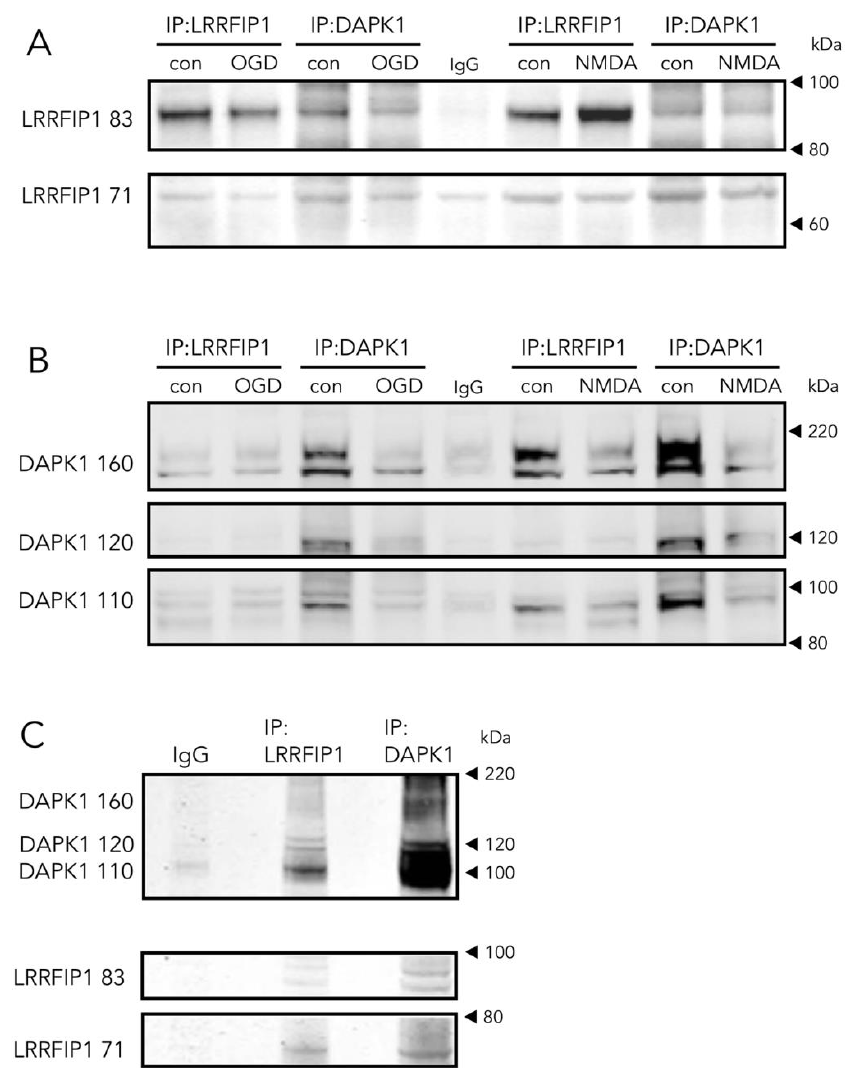
Figure 6. Direct and reverse co-immunoprecipitation of LRRFIP1 during ischemia in vivo and excitotoxicity in vitro . ( A , B ) WB showing the effect of OGD or NMDA on direct and reverse co-immunoprecipitation of LRRFIP1 and DAPK1 from rat cultured neurons. ( C ) WB showing direct and reverse co-immunoprecipitation of DAPK1 and LRRFIP1 from ischemic rat brain homogenates.